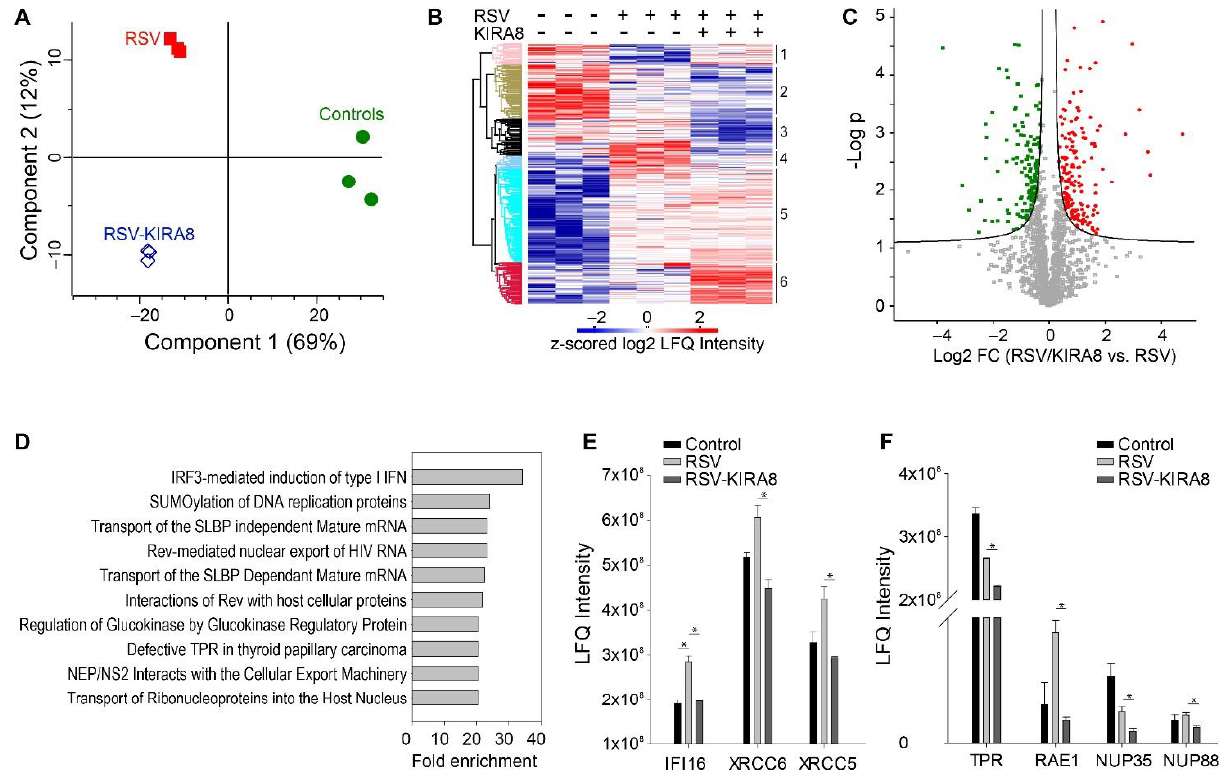
Figure 2. Proteomics analysis of hSAECs infected with RSV in the presence or absence of KIRA8. hSAECs were infected with RSV at 1.0 MOI for 24 h in the presence or absence of KIRA8 (10 µM). The proteins were analyzed with label-free LC-MS/MS. ( A ) Principal component analysis of significant proteins (ANOVA with permutation-based FDR < 0.01). Green circle, controls; red square, RSV infection; blue diamond, RSV infection + KIRA8 treatment. ( B ) Unsupervised hierarchical cluster analysis of 813 significant proteins. The colors of the heatmap represent the z-scored normalized log2 LFQ intensity of each protein. ( C ) Volcano plot of proteins (RSV+KIRA8 vs. RSV). Significantly proteins. Red circle, proteins upregulated by KIRA8; green square, proteins downregulated by KIRA8. ( D ) Top Panther Reactome pathways activated by RSV infection but blocked by KIRA8 (FDR < 0.05%). ( E ) Protein expression of IRF3-mediated type I IFN genes. ( F ) Expression of proteins involved in the interaction of viral structure protein NS2 with the cellular export machinery. Student’s t -test with permutation correction, *, q <